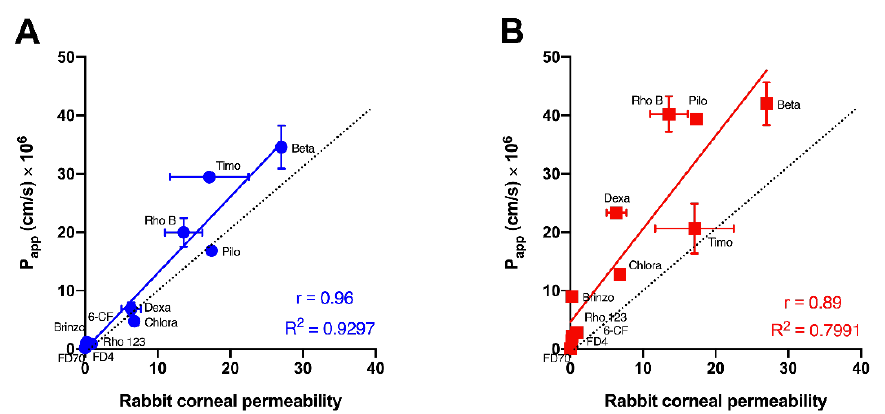
Figure 3. Linear regression between the apparent permeability coefficient, P app (cm/s) × 10 6 , of oph- thalmic drugs and reference molecules across in vitro hydrogel-based corneal mimetic ( A ), the human corneal cells grown conventionally in cell culture inserts ( B ), and rabbit corneal permeability values, respectively. The data refer to the mean ± SEM. Pearson’s correlation coefficients (r) for the in vitro corneal mimetic with hydrogel and the cells grown in cell culture inserts were r = 0.96 and 0.89, respectively. The dotted lines in the figures represent a perfect positive correlation (r = 1). The goodness of the correlation fit (R 2 value) describes how well the corneal mimetic in vitro model agrees with the corresponding rabbit corneal permeability values.